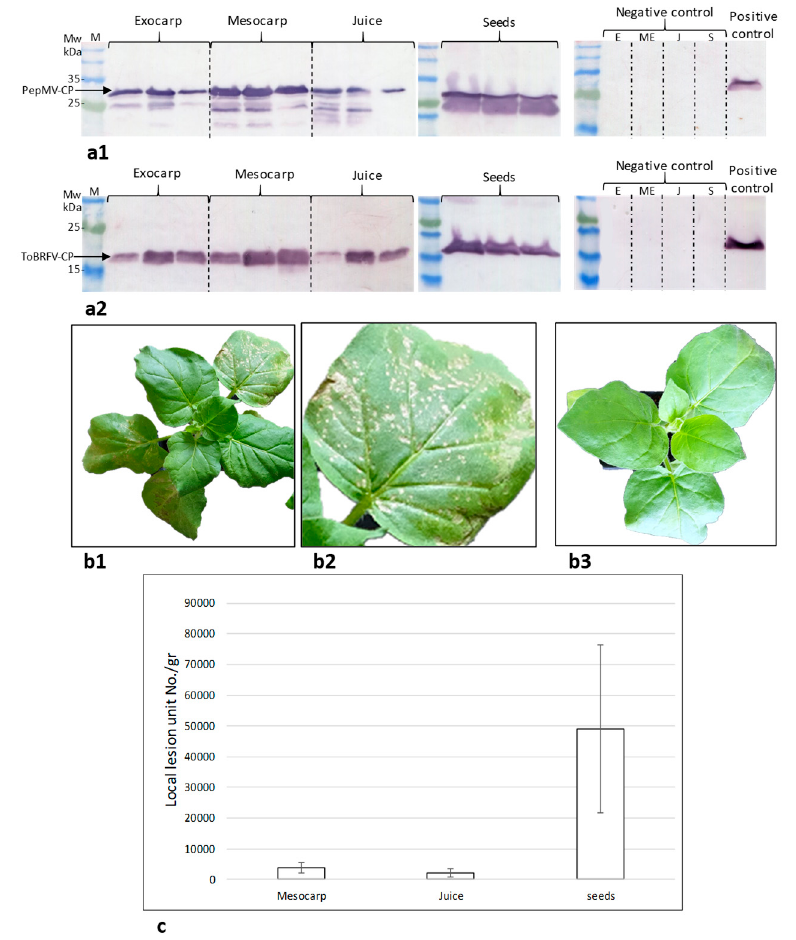
Figure 3. Infectivity potential of components of tomato brown rugose fruit virus (ToBRFV) and pepino mosaic virus (PepMV) co-infected tomatoes. ( a ) Western blot analyses of co-infected tomato fruit components; ( a1 ) PepMV coat protein (CP) detection in fruit components of three representative symptomatic fruits; ( a2 ) ToBRFV CP detection in fruit components of three representative symptomatic fruits; ( b1 ) A biological assay allowing visualization of ToBRFV induced local lesions on a representative Nicotiana glutinosa plant; ( b2 ) A close-up image of ToBRFV induced local lesions on a N. glutinosa leaf; ( b3 ) An untreated N. glutinosa plant; ( c ) ToBRFV-induced local lesion number on N. glutinosa leaves ( n = 27 for each test), in one gram of fruit mesocarp, juice or seeds; M, molecular weight; E, exocarp; ME, mesocarp; J, juice; S, seeds. 2.3. Symptomatic Co-Infected Tomato Fruits could Constitute a Source of Tomato Plant Viral Infection